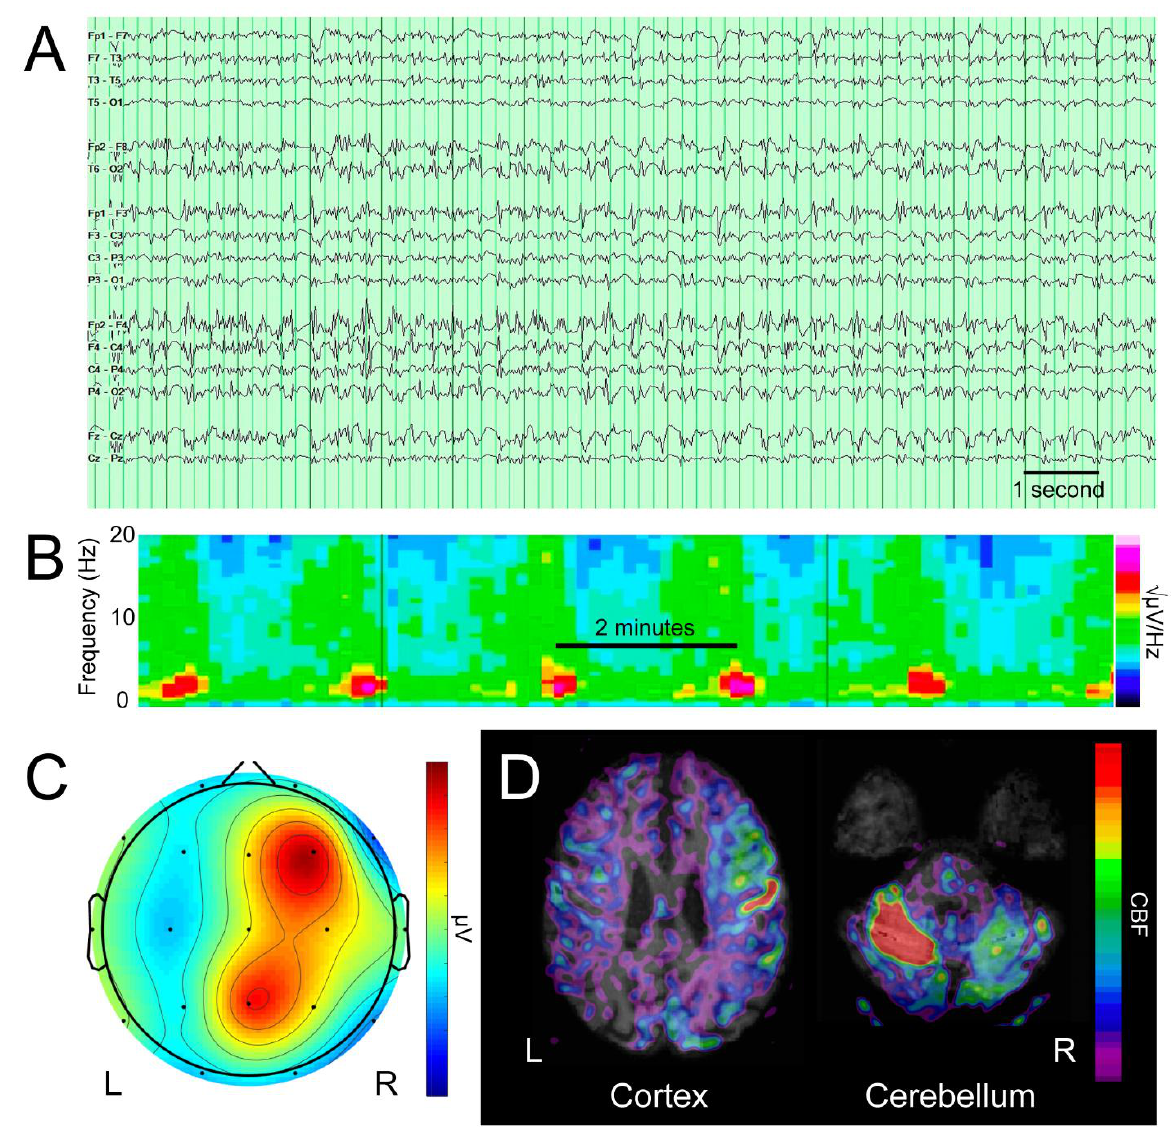
Figure 1. Clinical data . The patient’s electroencephalogram (EEG) is depicted in ( A ), the spectro- gram of discharge frequency depicted in ( B ), a representative topographic voltage distribution, in a Laplacian montage in ( C ), and arterial spin labeling MRI, revealing increased cerebral blood flow (CBF) in the right cortex and contralateral cerebellum in ( D